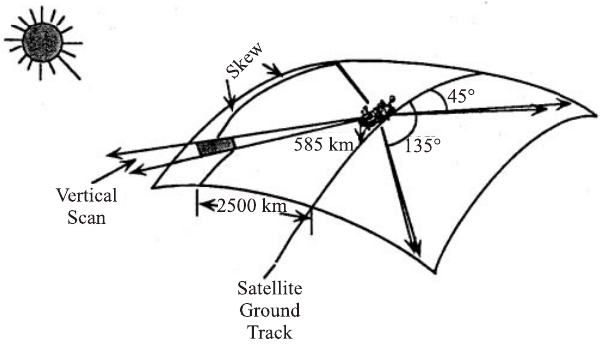
Fig. 1. HRDI viewing geometry (after Burrage et al. [1996]). The instrument obtains an observation in the shaded region, which is approximately 300 (cid:2) 300 km in horizontal extent. The telescope is then slewed through 90 degrees as the spacecraft moves in the direction indicated. The instrument then takes another measurement (on the same side of the satellite track) of the same region of atmosphere. These measurements are then combined and a velocity obtained for the relevant region of atmosphere